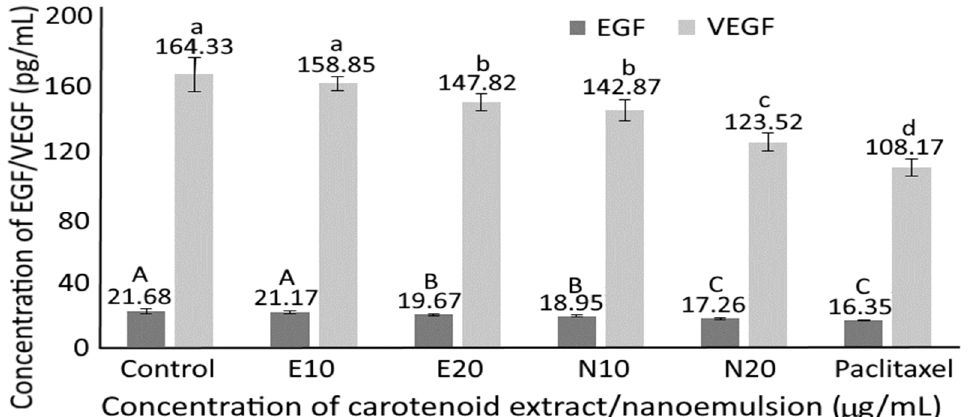
Figure 9. Effect of carotenoid extracts, carotenoid nanoemulsions and paclitaxel on serum EGF and VEGF levels in nude mice. E10 and E20, carotenoid extract concentration respectively at 10 and 20 μ g/mL; N10 and N20, carotenoid nanoemulsion concentration respectively at 10 and 20 μ g/mL; Paclitaxel, paclitaxel concentration at 10 μ g/mL. Results are presented as mean ± standard deviation of measurements from six nude mice ( n = 6). Data with different capital letters (A–C) for EGF and small letters (a–d) for VEGF are significantly different at p < 0.05.